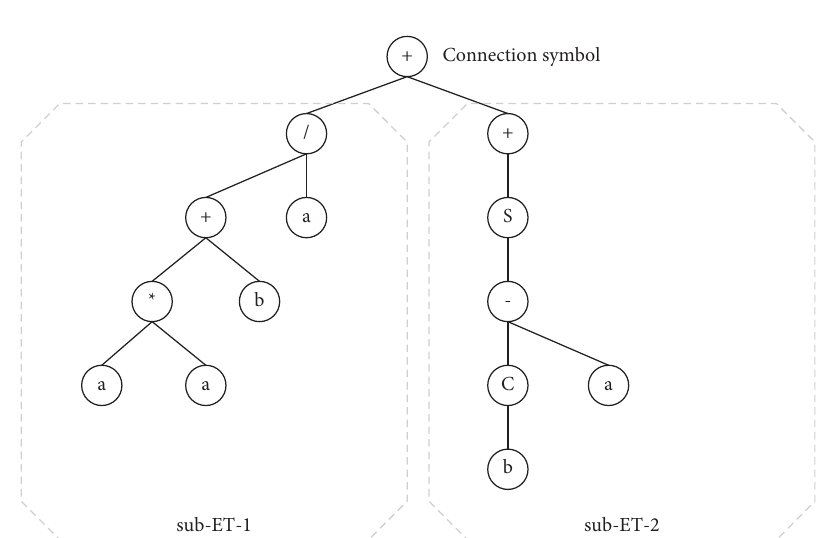
Figure 2: Corresponding expression tree generated by chromosome decoding in Figure